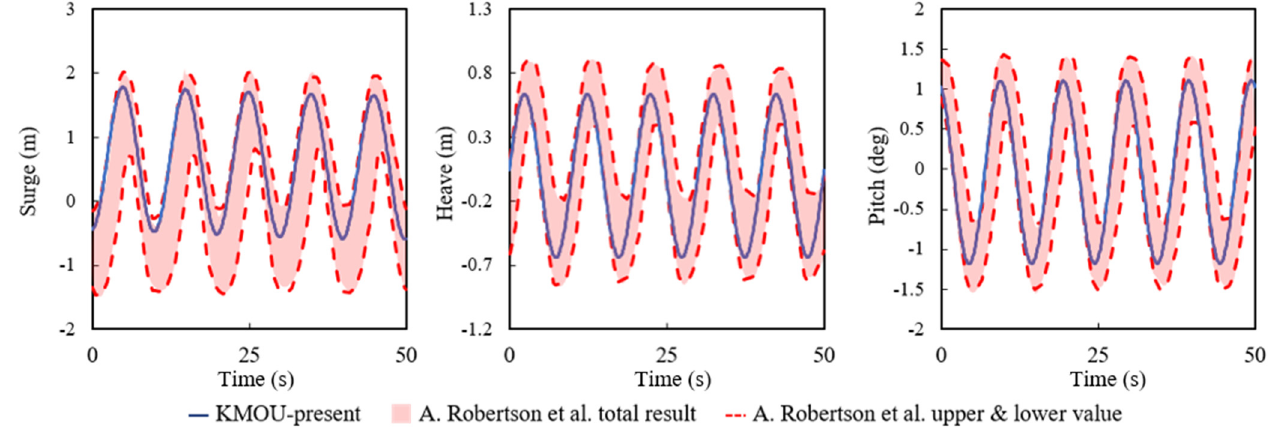
Figure 4. Fully coupled technique validation result (regular wave, H = 6 m, T = 10 s).